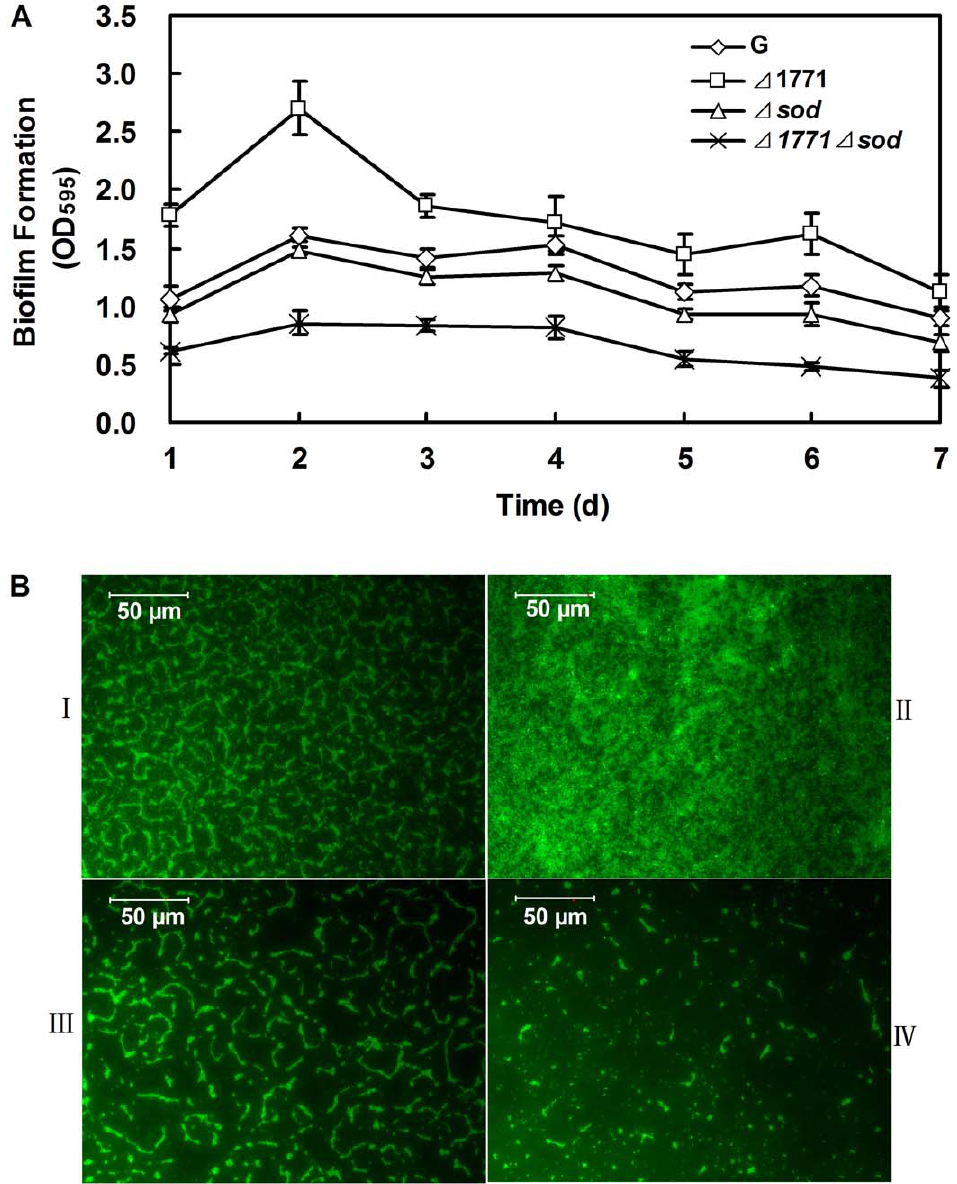
Figure 2. Quantification of the biofilms produced by different L.monocytogenes strains. (A) Microtiter plate assay: Biofilm was measured each day for cells inoculated in TSB broth with 96-well microtiter plate for 7 days. The experiments were repeated three times and error bars indicate the standard deviations. The T-test was used to calculate the p -value between the wild-type and mutants. (B) Microscope assay with 0.1% FITC. I: wild- type L. monocytogenes 4b G ; II: D 1771; III: D sod ; VI: D 1771 D sod . Cells from each strain for this method were incubated on glass slides for 3 days to